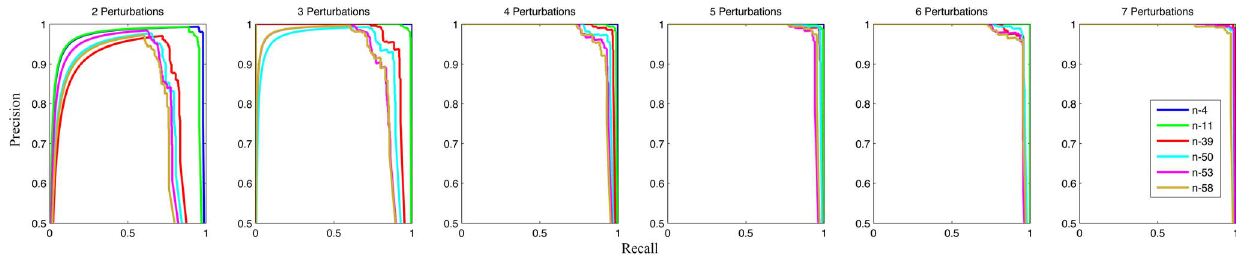
Figure 5. Precision-recall curves of network structure inference. The performance of structure inference, under 6 different numbers of perturbations (from 2 to 7), is evaluated by Precision-recall curves. Each subplot contains the inference results for 6 benchmark networks. The average AUPR is 0.95. More specifically, the maximum AUPR value 1.0 is achieved by the n-4 network (3–7 perturbations) and the n-11 network (6–7 perturbations), while the minimum AUPR value 0.75 is obtained by the n-58 network (2 perturbations).